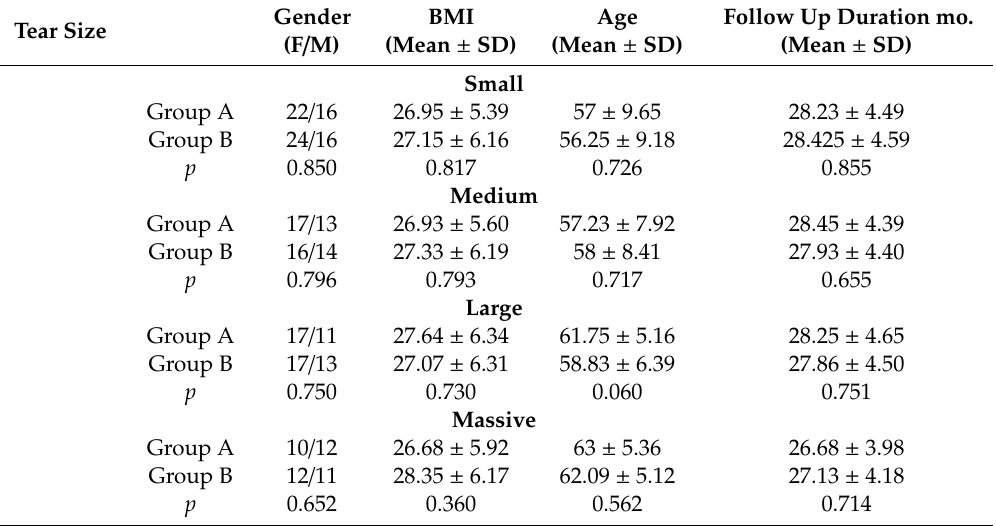
Table 1. Demographics and perioperative data of the 2 groups and 4 subgroups of patients. Tear Size